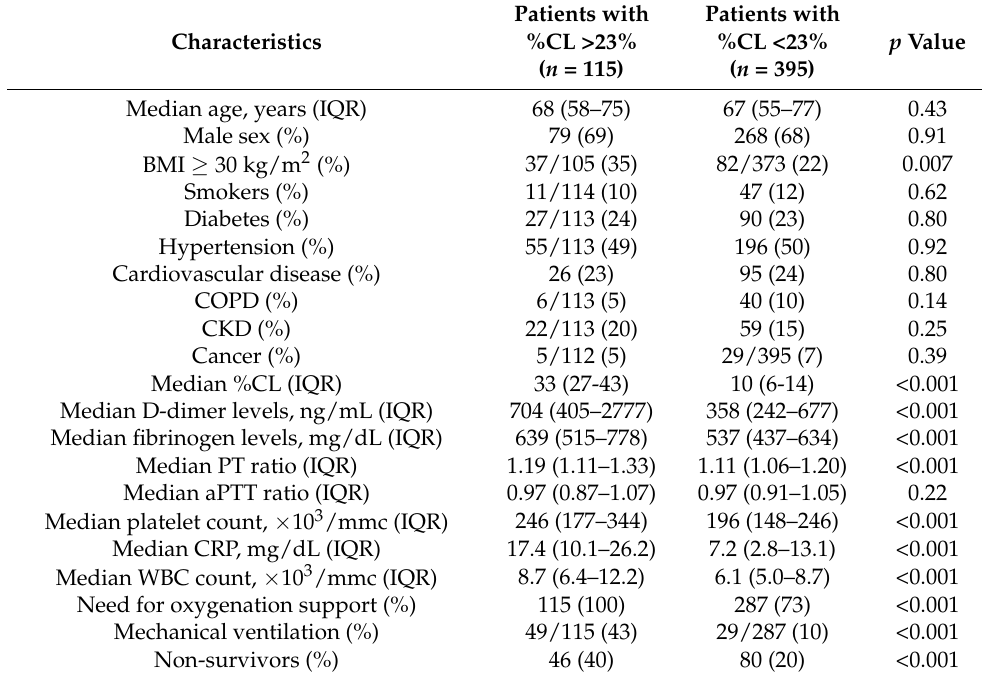
Table 3. Clinical and laboratory features of 115 patients with COVID-19 pneumonia and >23% of compromised lung as measured by QTC and comparison with 395 patients with COVID-19 pneumonia and <23% of compromised lung at